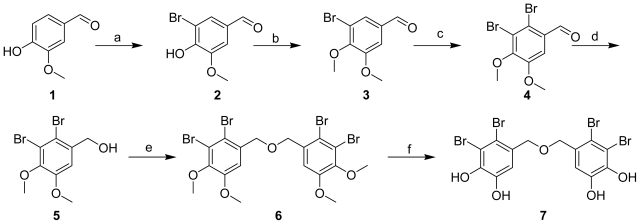
Reagents and Conditions: a: AcOH, Br2, r.t. 2 h; b: MeI, K2CO3, CH3CN, r.t., 4 h; c: AcOH, Br2, 60 °C overnight; d: NaBH4, MeOH, −20 °C to r.t., 3 h; e: TsCl, Et3N, CH3CN, reflux overnight; f: BBr3, CH2Cl2, 0 °C to r.t., 3 h.